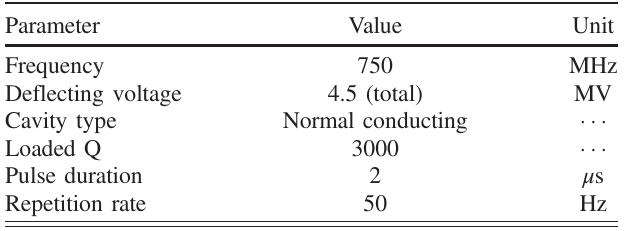
TABLE II. Parameters relevant to the PAL-4GSR lattice.